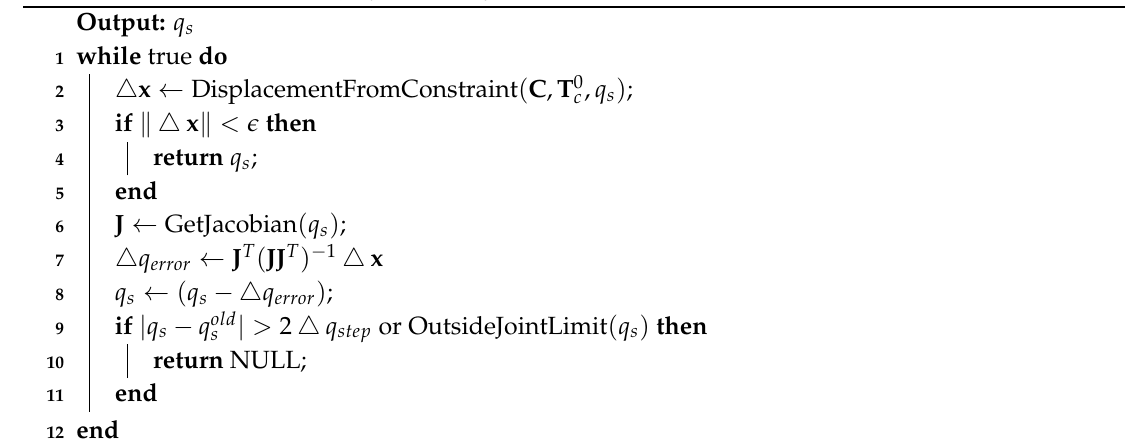
Algorithm 5: ProjectConfig( q old